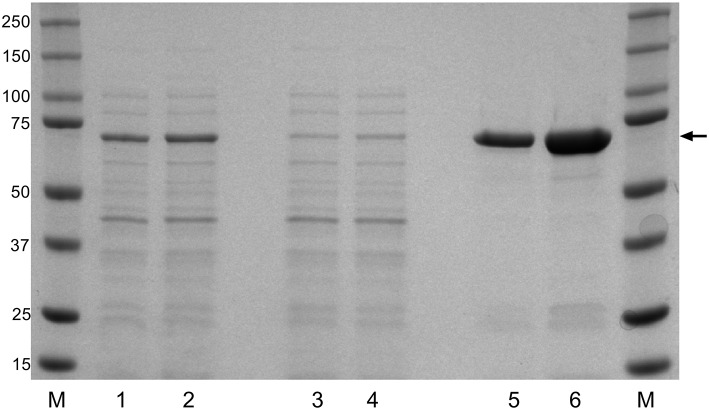
Recombinant expression of F. columnare DnaK protein (rDnaK). Coomassie stain of SDS gel of E. coli lysates (lanes 1 and 2); Ni-NTA column washes (lanes 3 and 4), and eluted protein fractions (lanes 5 and 6) after 4 or 6 h of IPTG stimulation, respectively. The arrow marks the 70 kDa band representing the approximate size of the eluted rDnaK protein. (M) The pre-stained Precision Plus marker (kDa) was used to estimate molecular mass.